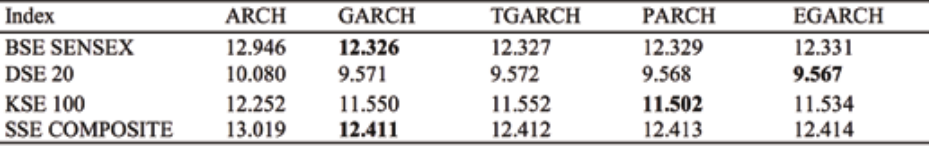
This table shows selection criteria undertaking Akaike information criterion. Table 3b: Model Selection Criterion – Schwartz Information